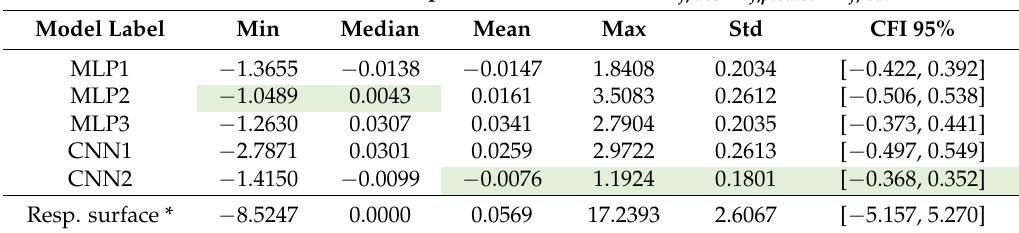
Table 4. Basic statistical indicators of fuel consumption ( V f ) predictions for both response surface- and NN-based energy demand models.